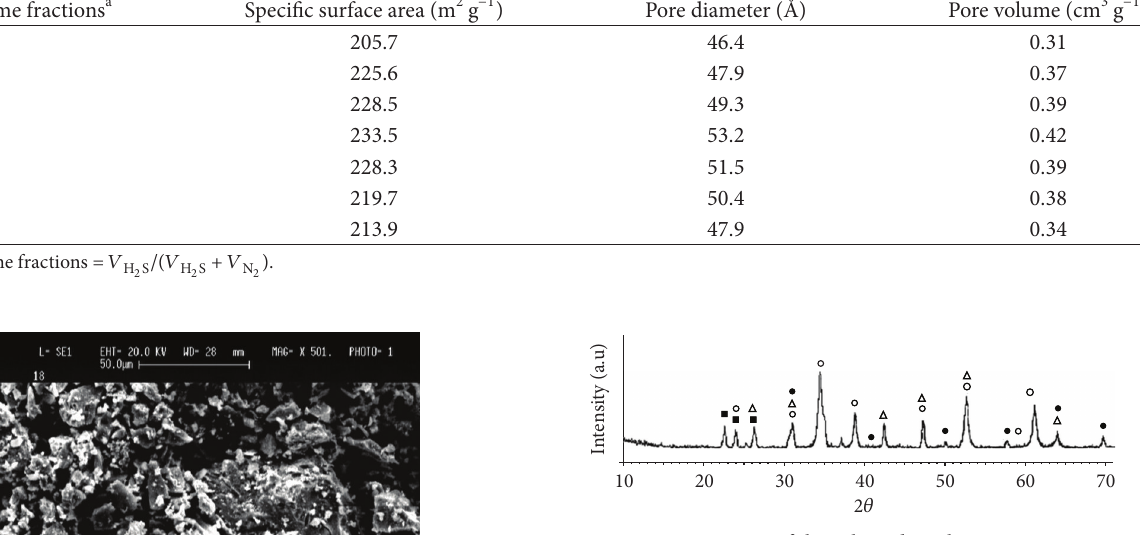
H S volume fractions a 2